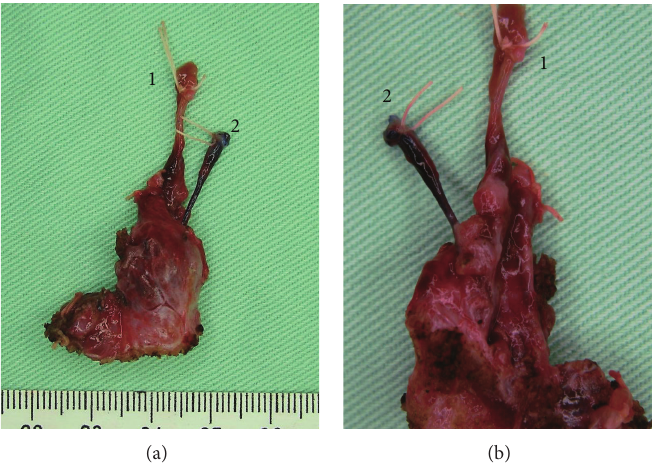
Figure 2: (a) Anterior view of the two resected tracts and a part of the thyroid. 1 shows a brownish tract that terminated at the upper part of the thyroid. 2 showed a crystal violet-stained tract that ended lower than the brownish tract and on the lateral side of the thyroid compared with 1 tract. (b) The posterior view of the resected tissue. The crystal violet-stained tract 2 was attached lower and more lateral than the brownish tract 1.